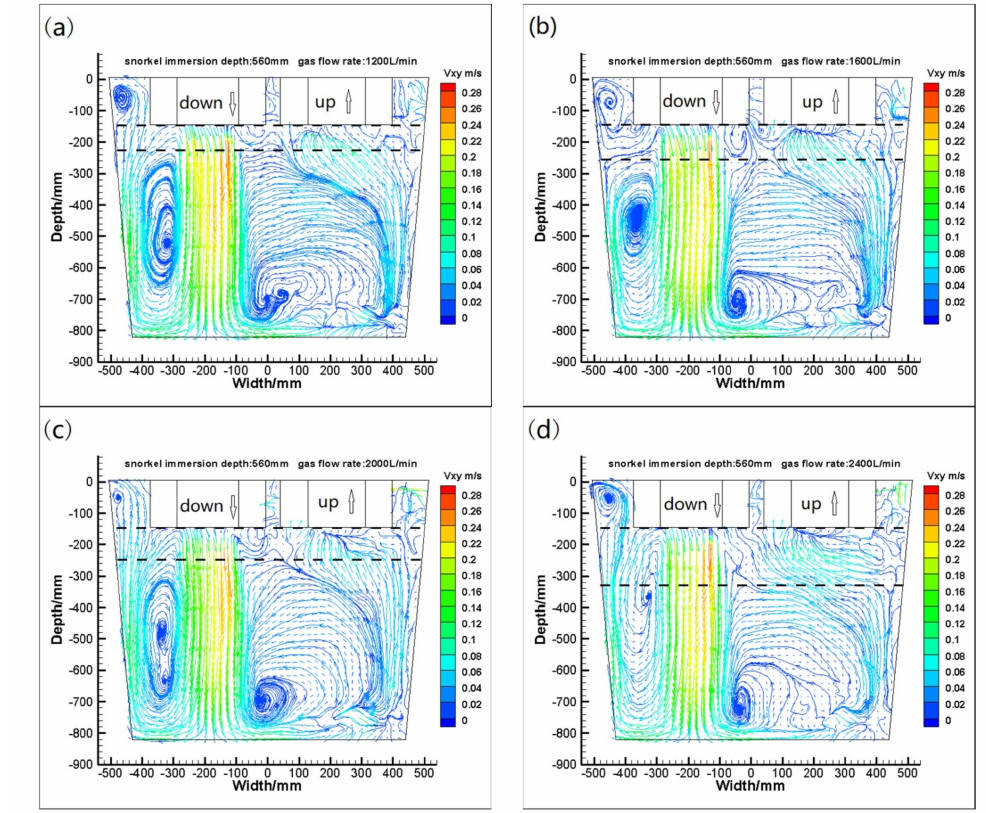
Figure 5. RH ladle flow field under di ff erent gas flow rates by PIV system: ( a ) 1200 L / min; ( b ) 1600 L / min; ( c ) 2000 L / min; ( d ) 2400 L /